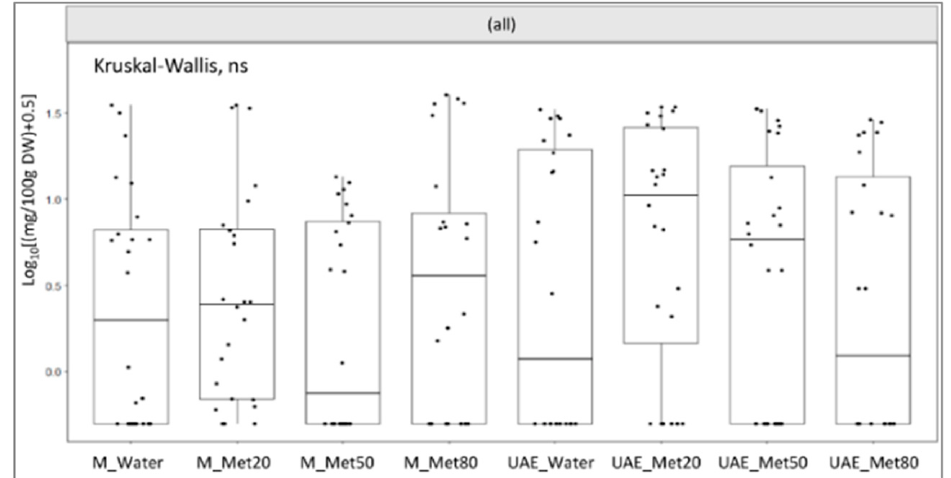
Figure 1. Effects of the extraction methods maceration (M) and Ultrasound Assisted Extraction (UAE) with the solvents water (M Water; UAE Water) and three concentrations of methanol in water (20%, Met20; 50%, Met50; 80% Met80; v:v) on the yield of all the compounds extracted and analyzed with HPLC-DAD. The extraction yield (mg 100 g − 1 of dried weight, DW) is expressed as log transformation. Statistical comparisons were performed using the Kruskal–Wallis test; ns = not significant.